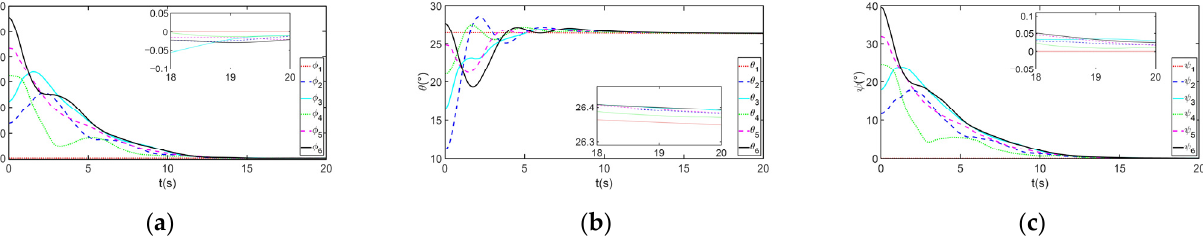
Figure 7. The attitude of the swarm utilizing SRP systems or NP systems: ( a ) Roll attitude; ( b ) Pitch attitude; ( c ) Yaw attitude.